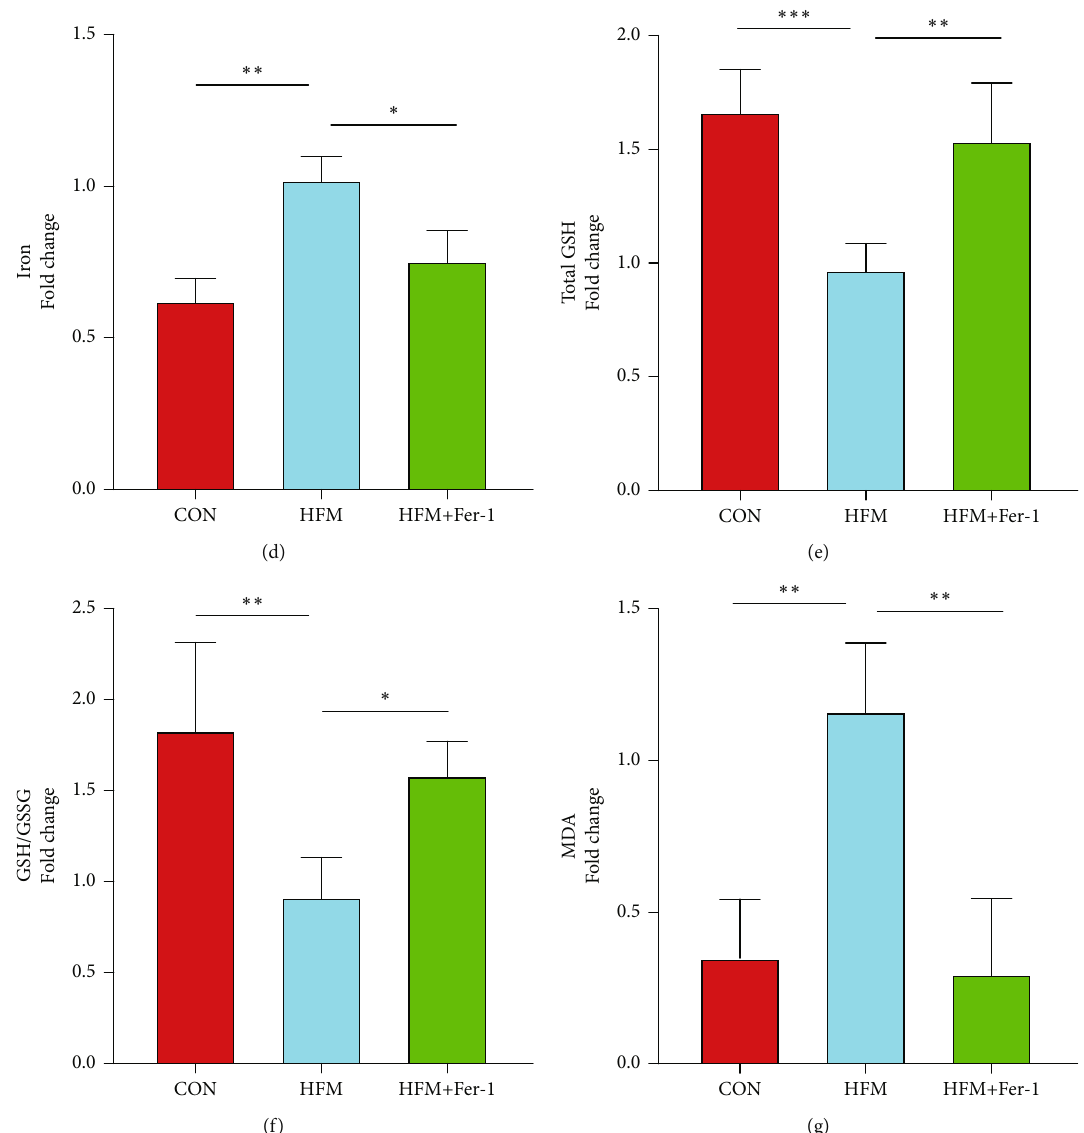
Figure 4: Mc3t3-E1 cells were used as cells for the in vitro study. Mc3t3-E1 cells were treated with high-fat medium for 24 hours, and Fer-1 at a concentration of 5 μ mol/l was used to slow down the process of ferroptosis. 24 hours later, changes in the key ferroptosis proteins Gpx4 and Slc7a11 were measured (a, b), while there was also a signi fi cant decrease in cell proliferation capacity (c), a process that could be rescued by ferroptosis inhibitors. Some of the treated cells were also used to assay ferroptosis biochemical parameters, and intracellular iron (d), total GSH (e), GSH/GSSG (f), and MDA (g) were found to vary in the high-fat medium. n = 3/group , ∗ P < 0 : 05 , ∗∗ P < 0 : 01 , ∗∗∗ P < 0 : 001